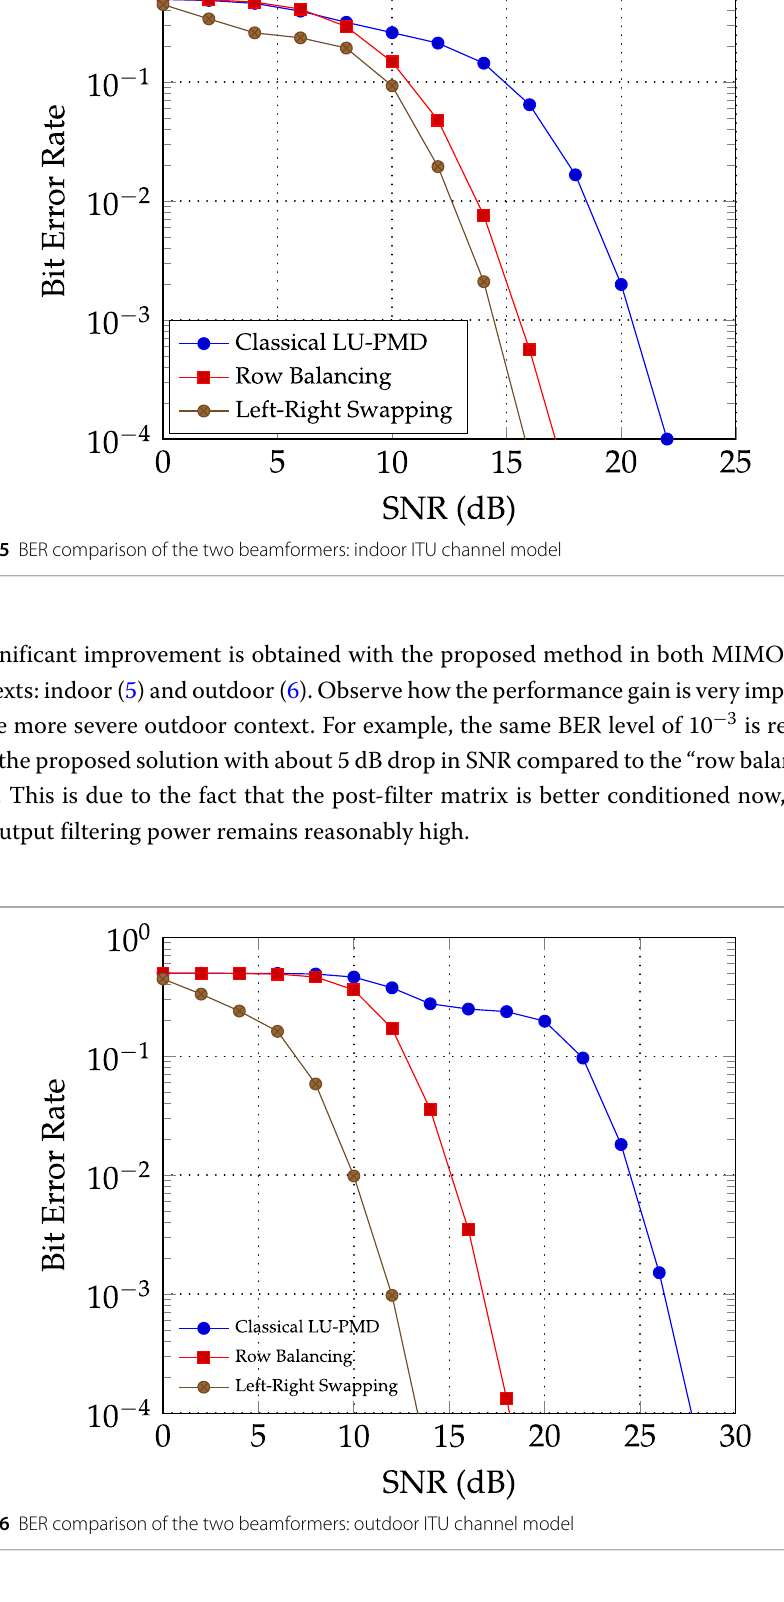
Fig. 6 BER comparison of the two beamformers: outdoor ITU channel